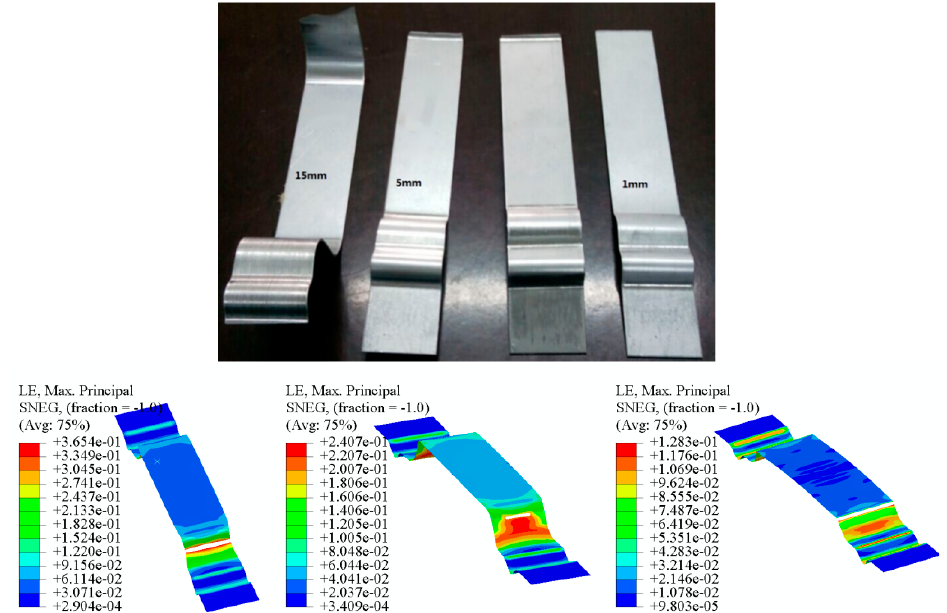
Figure 21. Results and numerical simulation diagram of tensile bending specimens with different fillets (the rounded corners from left to right are 15 mm, 5 mm, and 1 mm, respectively).